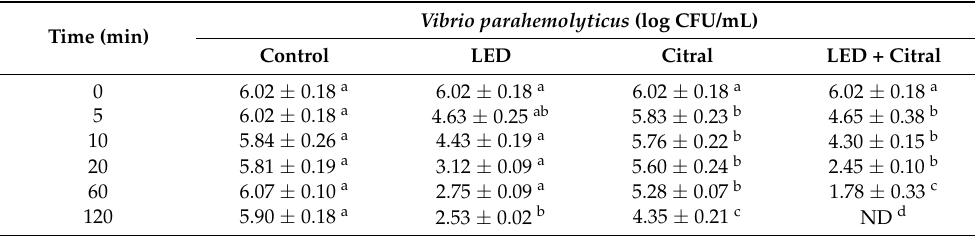
ND: Not detected. Different letters indicate significant ( p < 0.05)